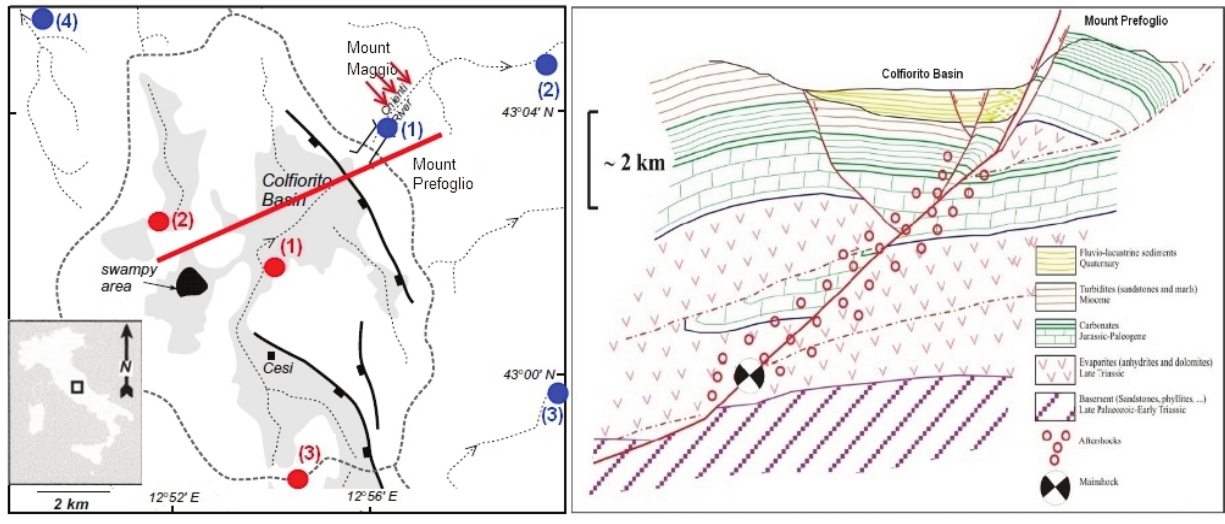
Figure 1. Colfiorito Basin. The red arrows in the left-hand box indicate cow movements, while red circles indicate the stronger shocks and blue circles indicate meteorological stations at Serravalle (1), Gelagna Alta (2), Pié del Sasso (3) and Bagnara (4) (the Nocera Umbra station is outside of the map to the west near Bagnara). A section of the Basin in the left-hand box is shown in red, it is represented in the right-hand box with the positions of the main shock and aftershocks along the normal fault plane in red; Mount Maggio is behind Mount Prefoglio, after Barchi